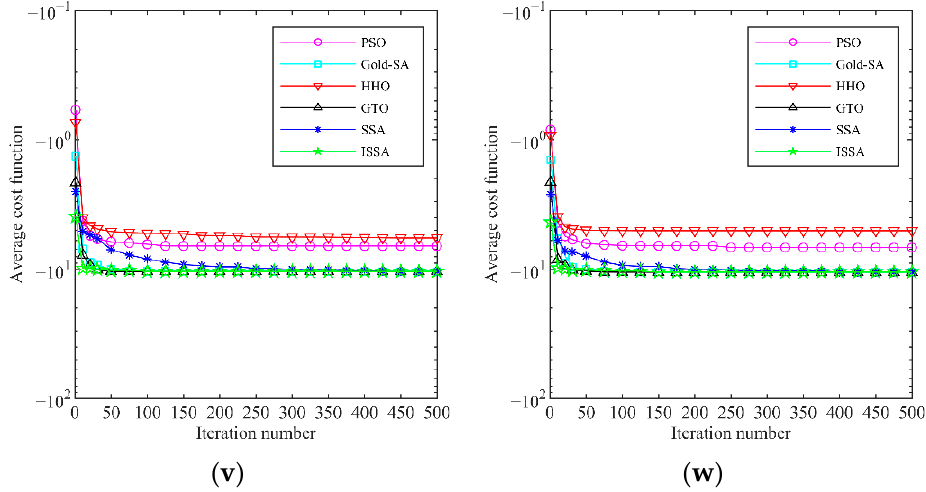
Figure 3. Convergence curve of benchmark function: ( a ) F 1 : Sphere; ( b ) F 2 : Schwefel 2.22; ( c ) F 3 :